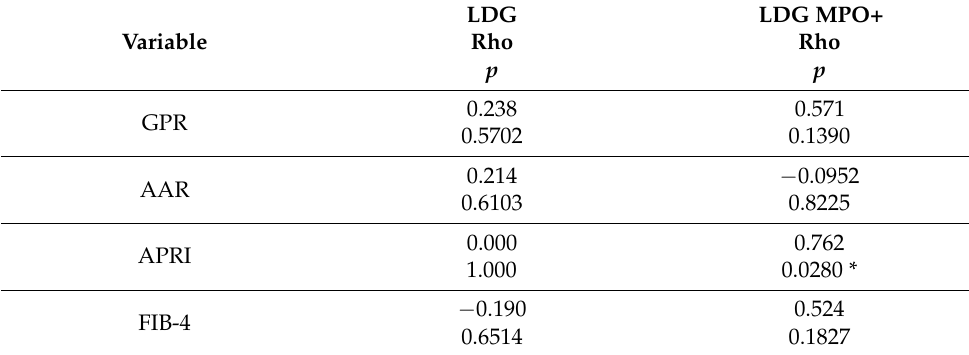
Table 5. Correlation between the percentage of LDG, including the fraction showing MPO expression with selected laboratory indices reflecting liver fibrosis in the group of patients with